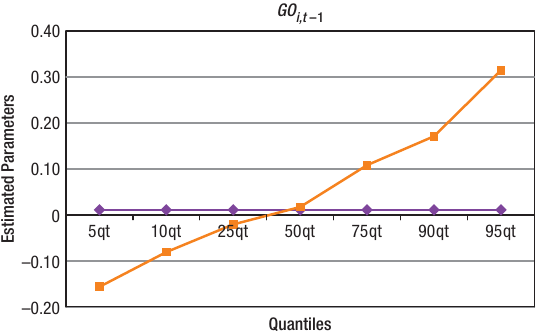
Fig. 5. Estimated parameters of relationship between I Notes: 1. The linear relationship represents OLS regression. 2. The non-linear relationship represents quantile